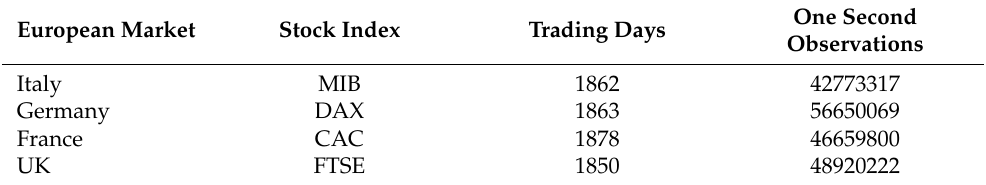
Table 1. Summary of high-frequency data observed from 4 January 2010 to 28 April 2017. European Market Stock